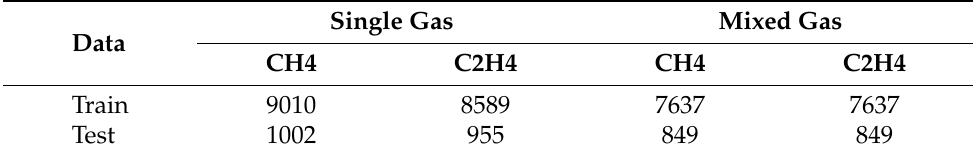
Table 4. The number of feature subset